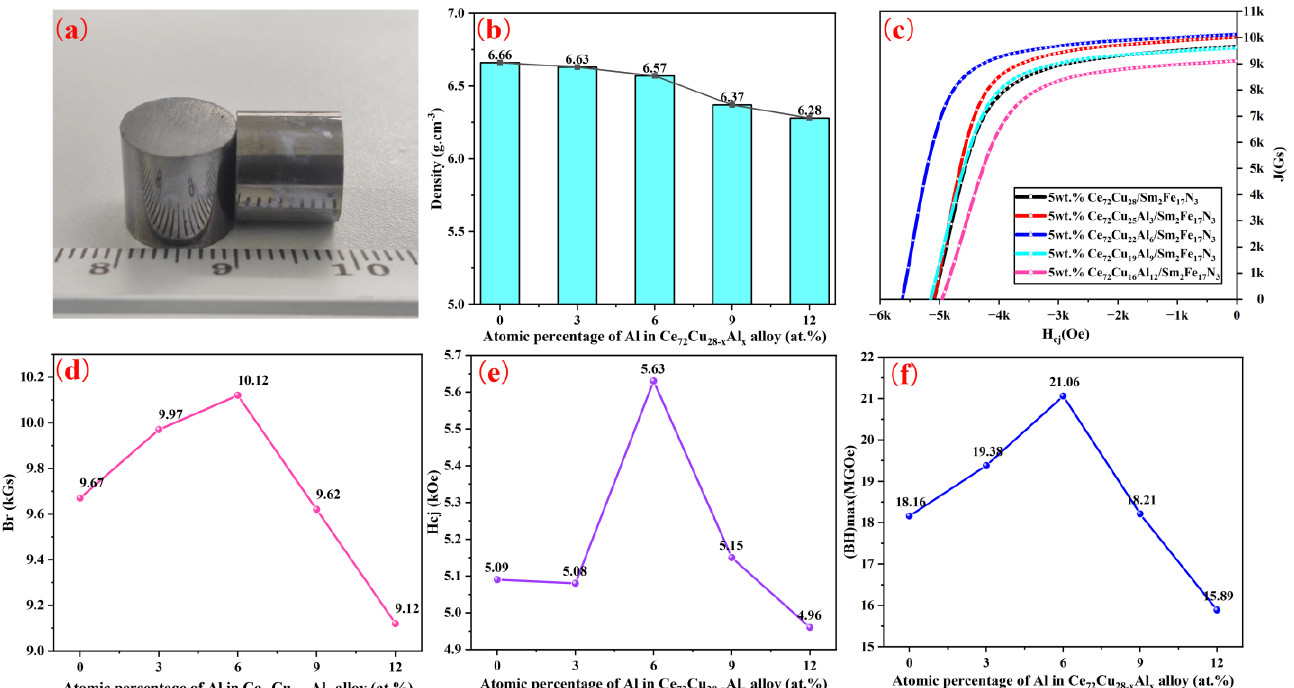
Figure 4. VSM diagram of Ce 72 Cu 28-x Al x alloys and their partial magnification. To determine the effect of Ce-based alloy binders with low melting points and weak magnetic characteristics on the magnetic properties of the Sm-Fe-N magnet, the Ce 72 Cu 28-x Al x /Sm 2 Fe 17 N green compacts with 5 wt.% alloy addition were consolidated by the hot- press sintering method. The appearance, density and magnetic properties of the bonded magnets are shown in Figure 5. With the increase in Al content, the density of the magnets decreases gradually, from 6.66 g/cm 3 at x = 0 at.% to 6.28 g/cm 3 at x = 12 at.%. In contrast, the remanence, coercivity, and maximum magnetic energy product increase first and then decrease, reaching the maximum values of 10.12 kGs, 5.63 kOe, and 21.06 MGOe when the atomic percentage of Al is 6 at.%.